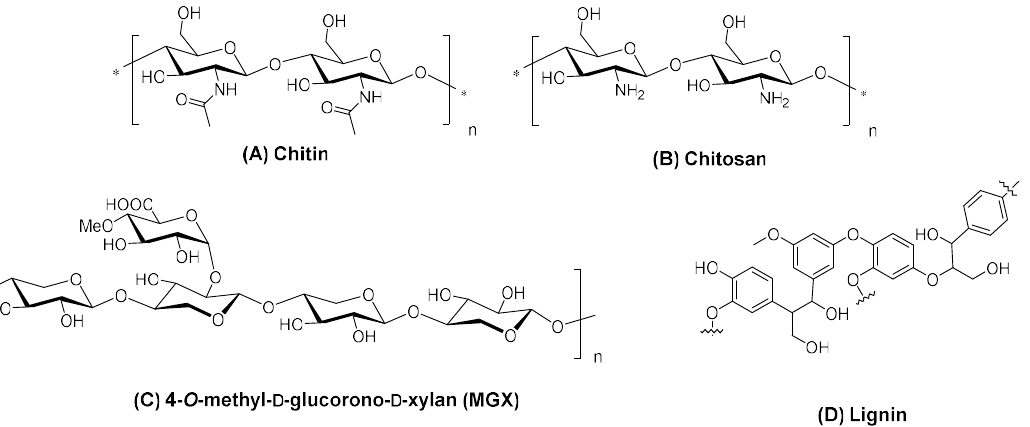
Figure 28. General structures for biopolymers also considered as supports in this review.; ( A ) Chitin, ( B ) Chitosan; ( C ) Xylan; ( D ) Lignin.